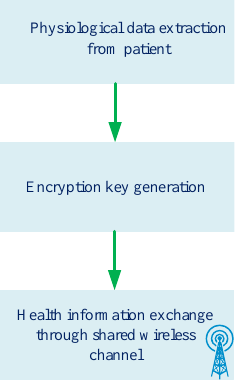
Figure 10. Intrawearable security